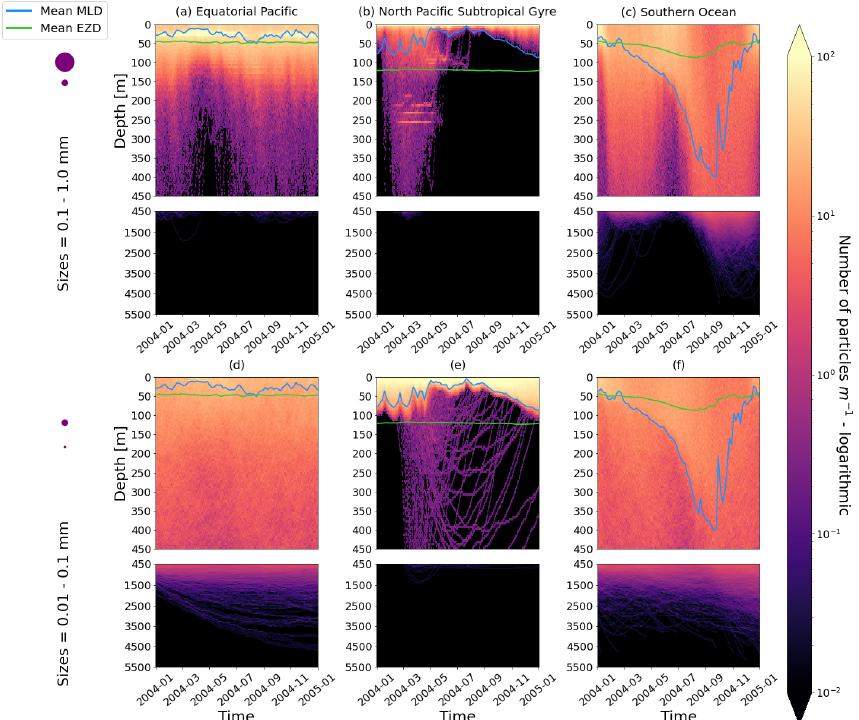
Figure D1. As in Fig. 2 but for particles where the biofilm death allows for denser algal frustules to remain attached (see description in Appendix D). The trajectories mostly remain unchanged for the larger size class; however the smaller size class has deeper trajectories and longer oscillation